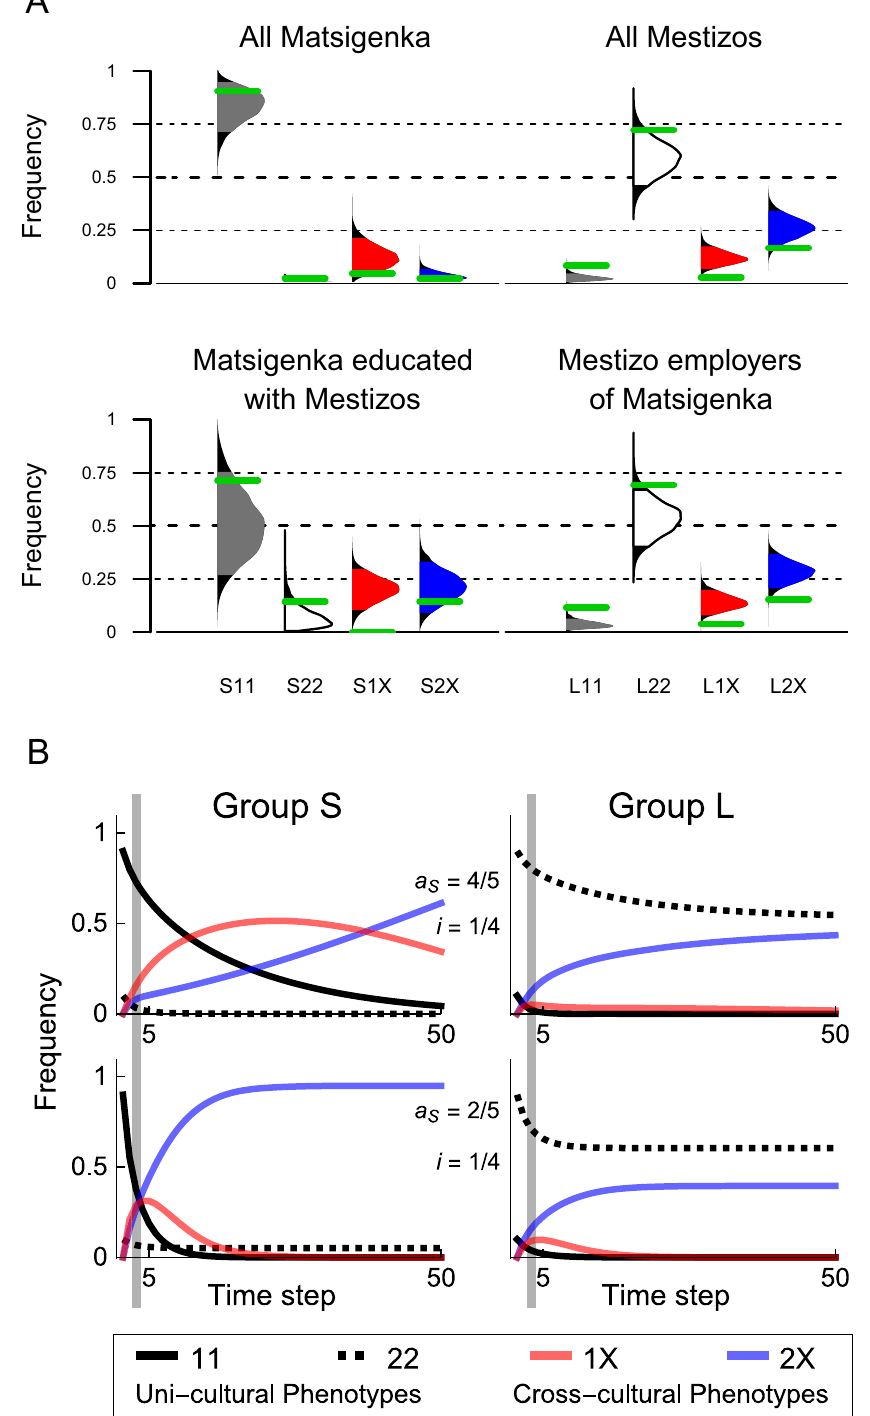
Fig. 1 Comparison of empirical data to the theoretical model. A Posterior IRT estimates of the mean frequencies of CCC (1 X and 2 X ) and UCC (11 and 22) phenotypes (standardized to sum to one) among minority Matsigenka (group S ) and majority Mestizos (group L ), with respect to norms of fairness. Top row: all individuals. Bottom row: individuals with particular inter-ethnic experiences. Black regions bound 90% highest posterior density intervals (McElreath, 2020). Green: standardized proportions of all 57 Matsigenka and 46 Mestizo participants (top), and the 10 Matsigenka and 34 Mestizos with particular inter-ethnic experiences (bottom). B Phenotype frequency trajectories for the low-power minority group ( S ) and high-power majority group ( L ) simulated from the full model where: ( b S , b L ) = (1, 0), c = 0.1, μ = m = 1, i = 0.25, and initial phenotype frequencies p S 11 = p L 22 = 0.9, p S 22 = p L 11 = 0.1, for low (top) and high (bottom) inter-group interaction: ( a S , a L ) = (0.8, 0.9) and (0.4, 0.7), respectively. To implement the assumed group size difference, changing a S necessarily changes a L (Appendix B.2.1). Vertical gray lines indicate time steps where empirical frequencies and model predictions approximately coincide (see also Appendix